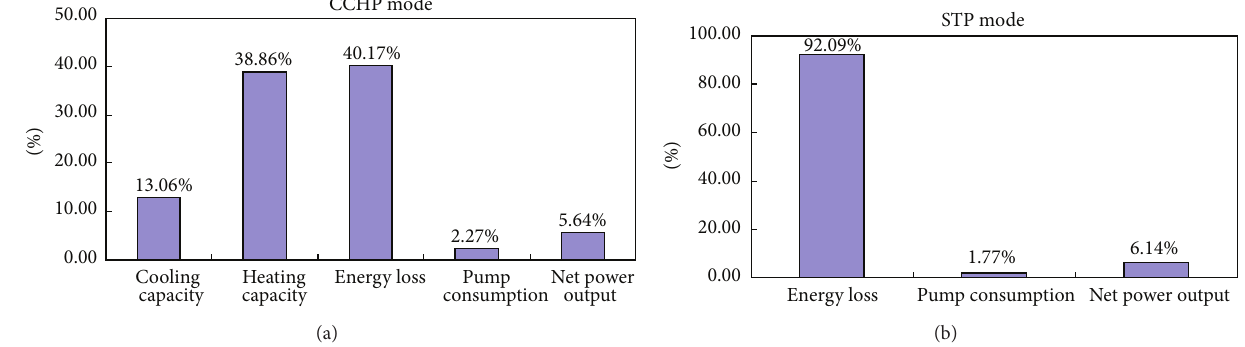
Figure 4: Energy utilization profiles of operation modes A (CCHP) and E (STP).